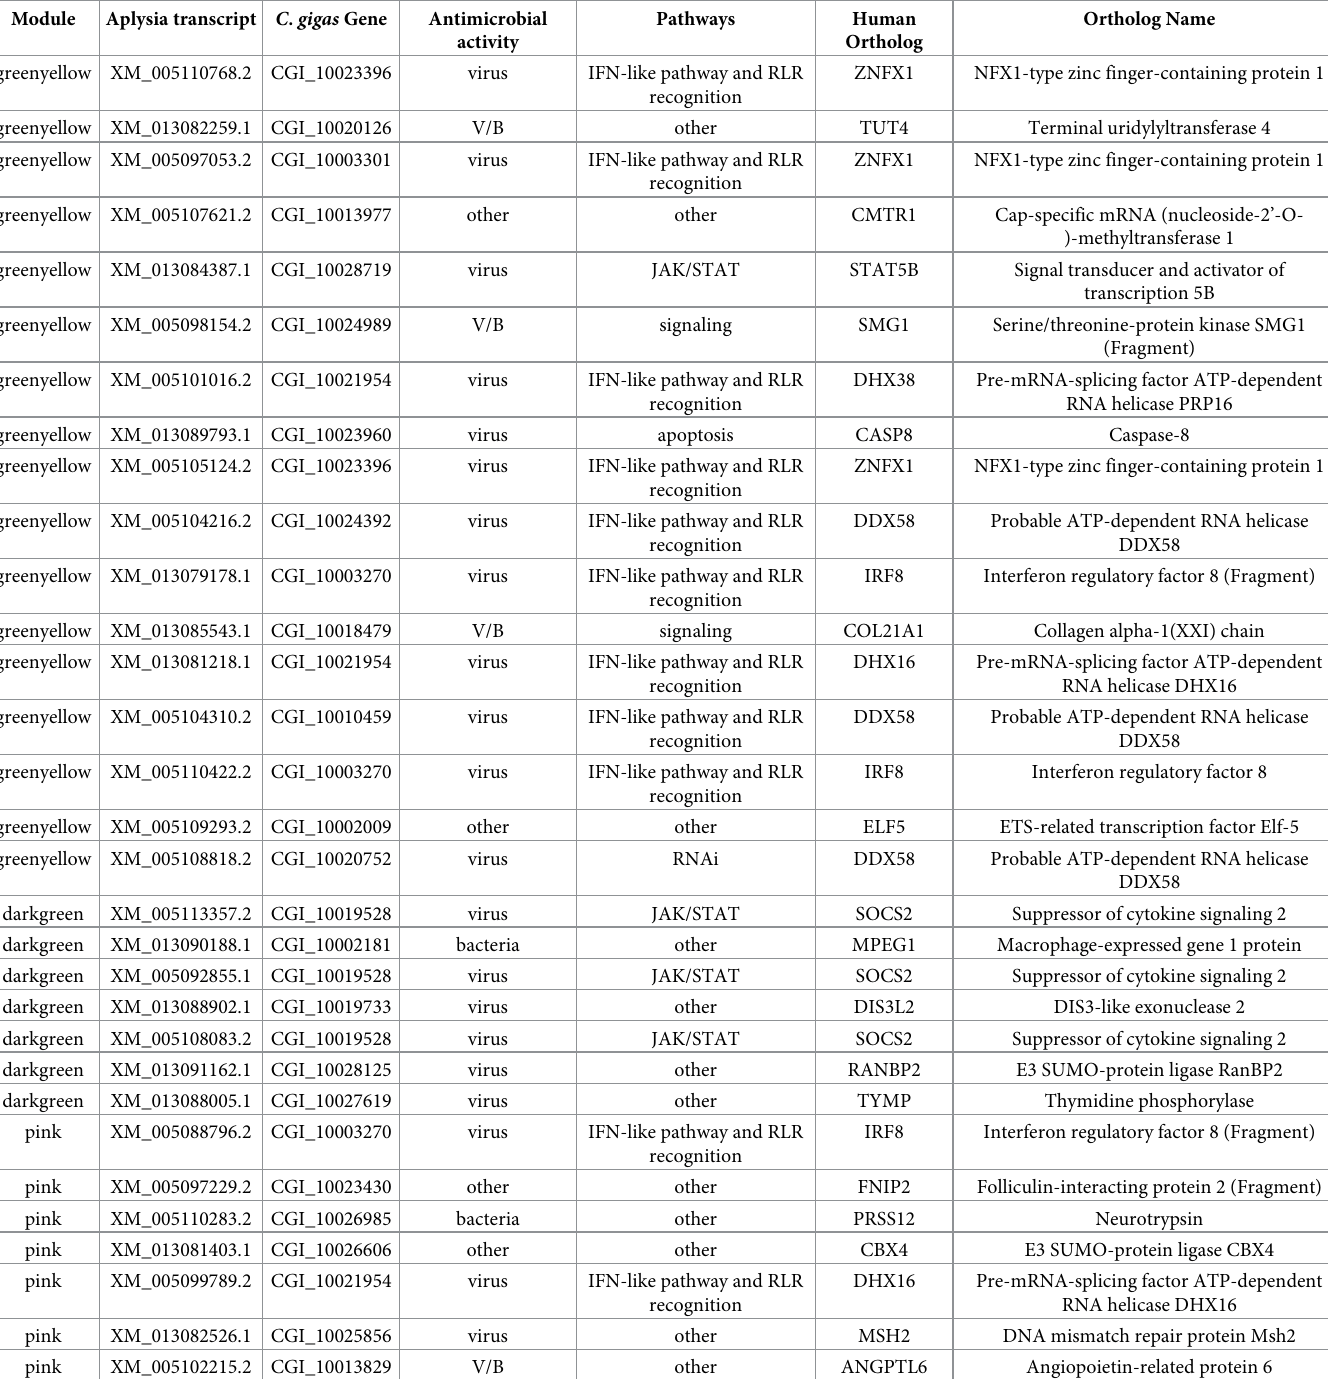
Table 8. Mapping between Aplysia transcripts with high module membership in the greenyellow, darkgreen, and pink modules and genes differentially expressed as a result of immune priming and viral exposure in C. gigas .